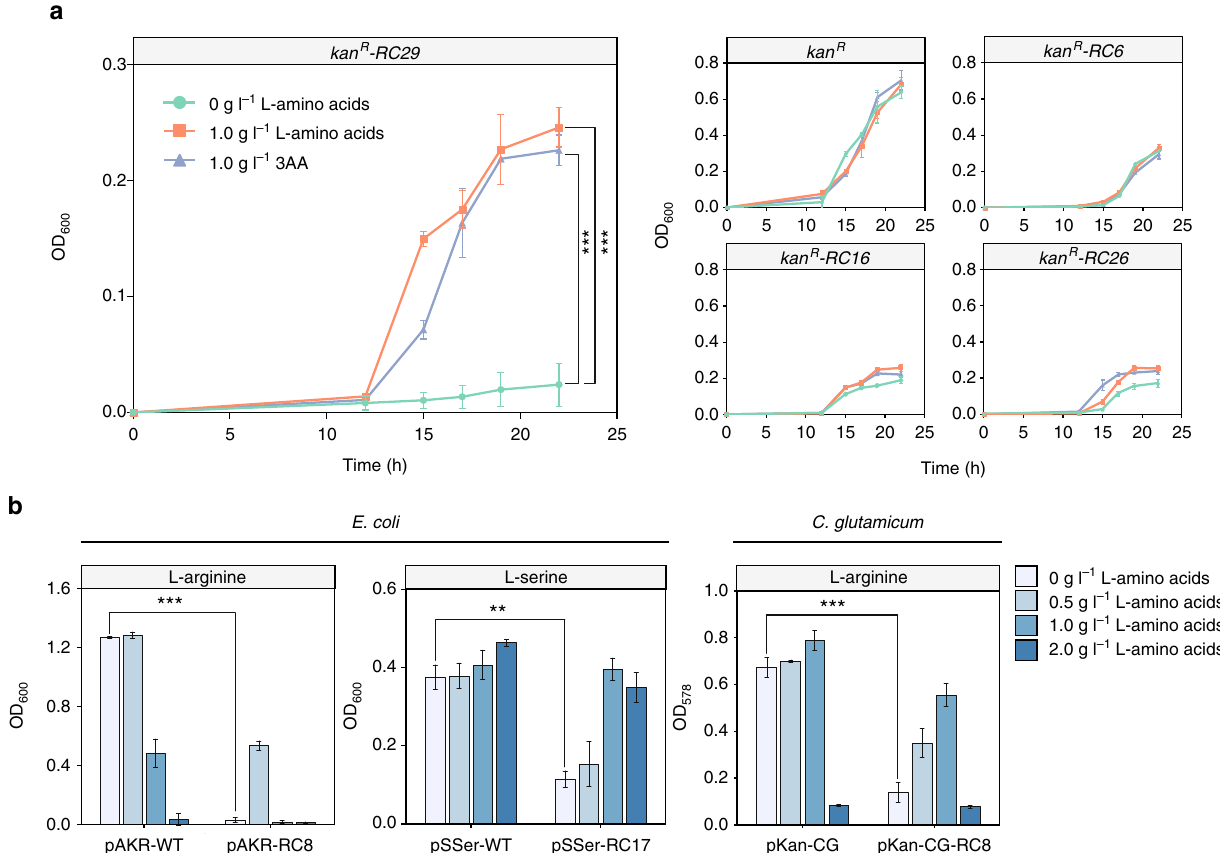
Fig. 3 Cell growth restored by feeding the corresponding L -amino acids. a Effects of feeding L -leucine or a mixture of three amino acids (3AA: L -leucine, L - valine and L -isoleucine) on the cell growth for E. coli strains harboring kan R genes with 6 − 29 leucine rare codons ( kan R -RC6 , kan R -RC16 , kan R -RC26 , kan R - RC29 ). b Changes in cell ODs after feeding L -arginine to E. coli and C. glutamicum strains harboring kan R genes in which eight arginine codons were replaced by its rare alternatives (encoded by pAKR-RC8 or pKan-CG-RC8), and the growth restoration after feeding L -serine to E. coli strains carrying spec R which was rich in serine rare codon (encoded by pSSer-RC17). Values and error bars represent the mean and the s.d. ( n = 3). ** P < 0.01, *** P < 0.001 as determined by two-tailed t